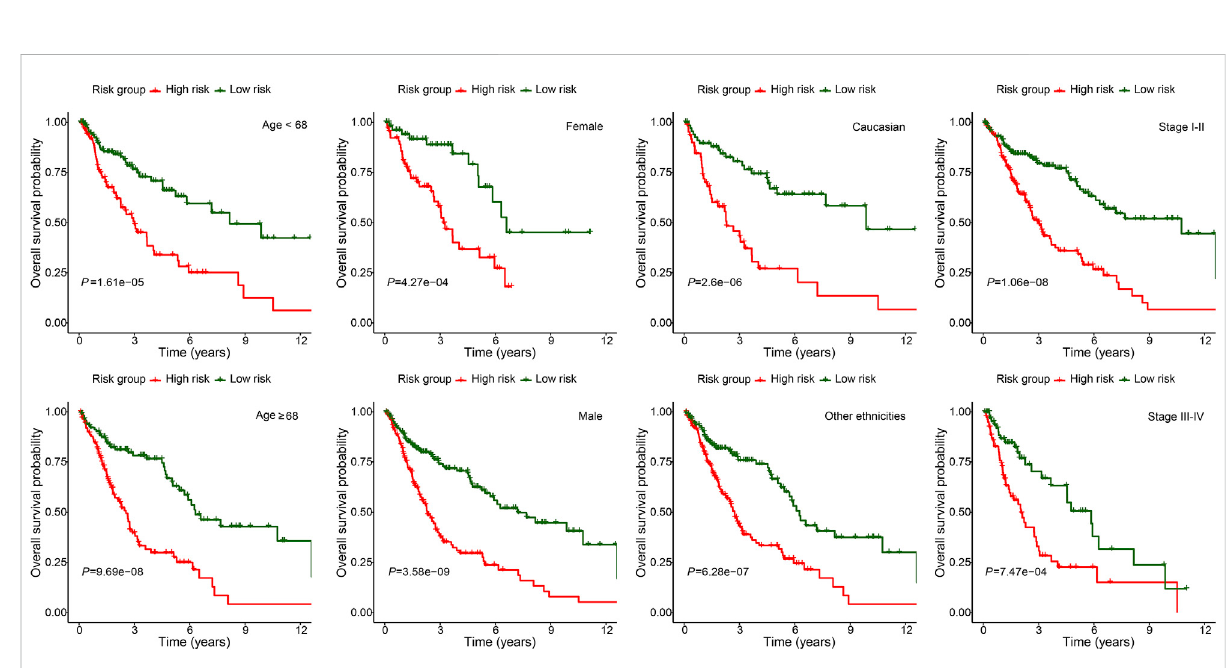
FIGURE 5 SubgroupoverallsurvivalanalysisoftheFerRLSigstrati fi cationbydifferentage,gender,ethnicitiesandTNMstagesubgroupsintheTCGA-LUSC entire